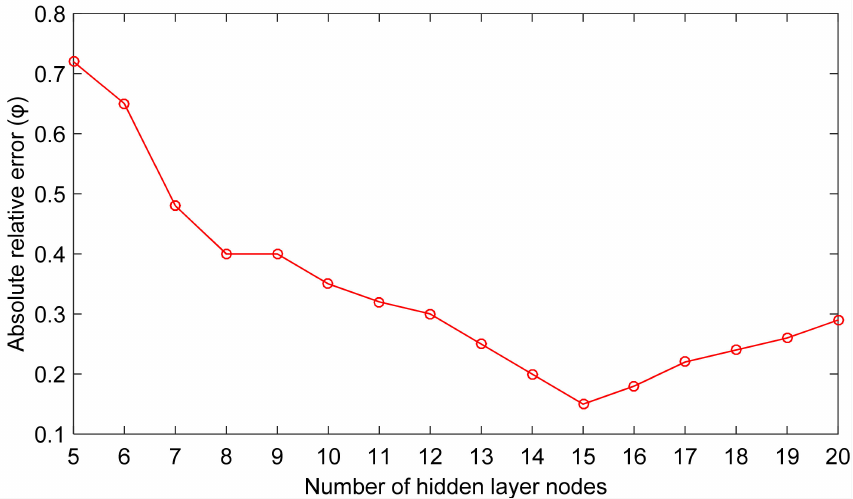
Figure 2. The errors corresponding to the number of hidden layer